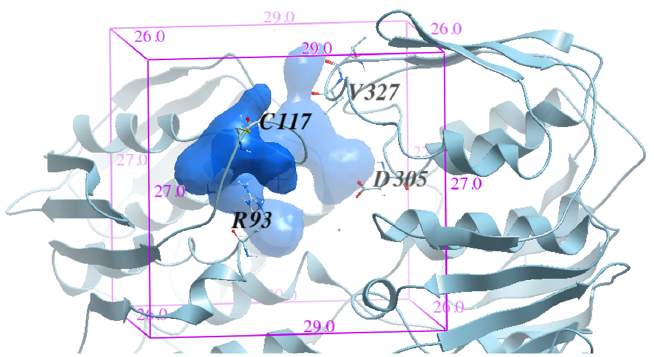
Figure A3. The docking box generated for docking-based virtual screening. The ligand binding pocket (blue) was predicted by ICM with a recommended tolerance level 4.6, which covers the enzyme active site (C117, R93, D305, and V327). The docking box (purple) was generated around the pocket with a size of 29 × 26 × 27 Å. The initial docking position was at the center of the box.